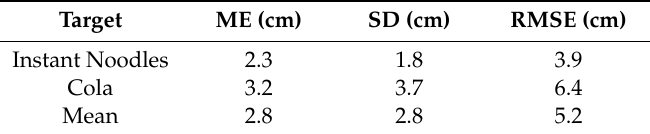
Table 1. Statistics of single target localization results.